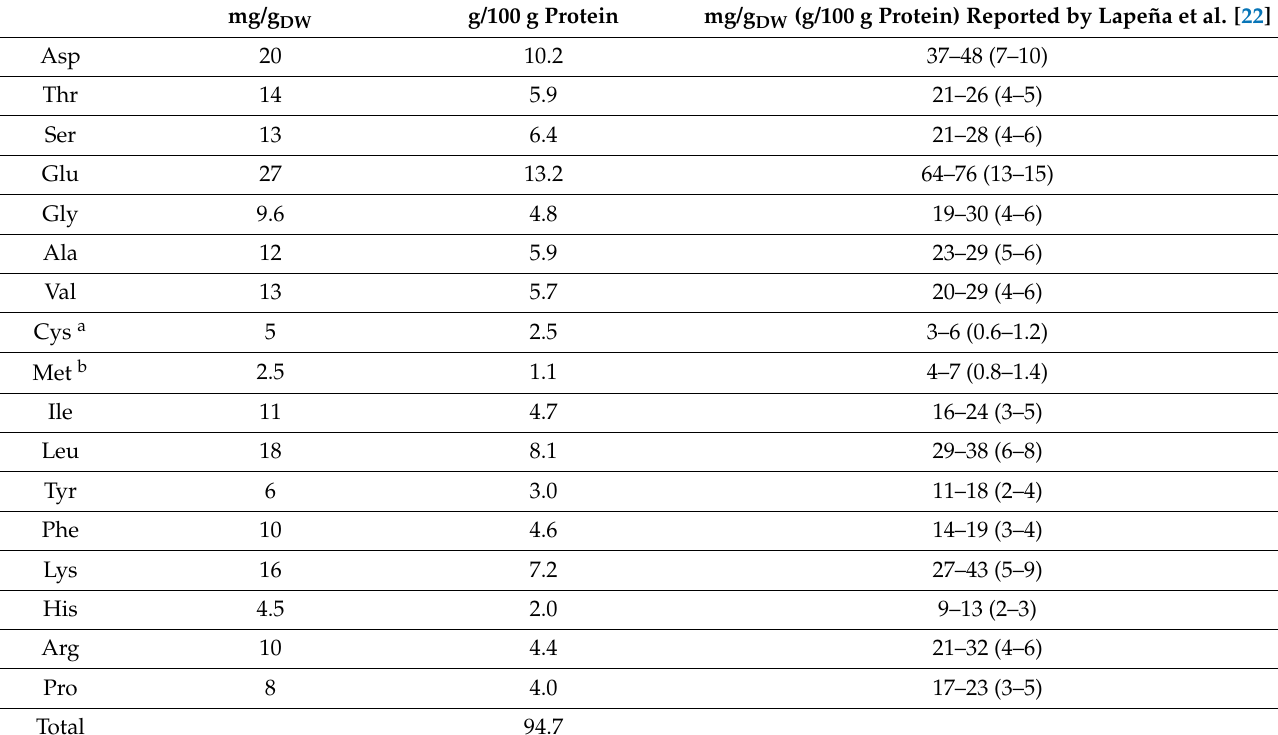
Table 2. Amino acid composition of Mo40 biomass obtained after growth in industrial-like seawater-based medium containing glucose and xylose (IMSS). mg/g DW g/100 g Protein mg/g DW (g/100 g Protein) Reported by Lapeña et al.